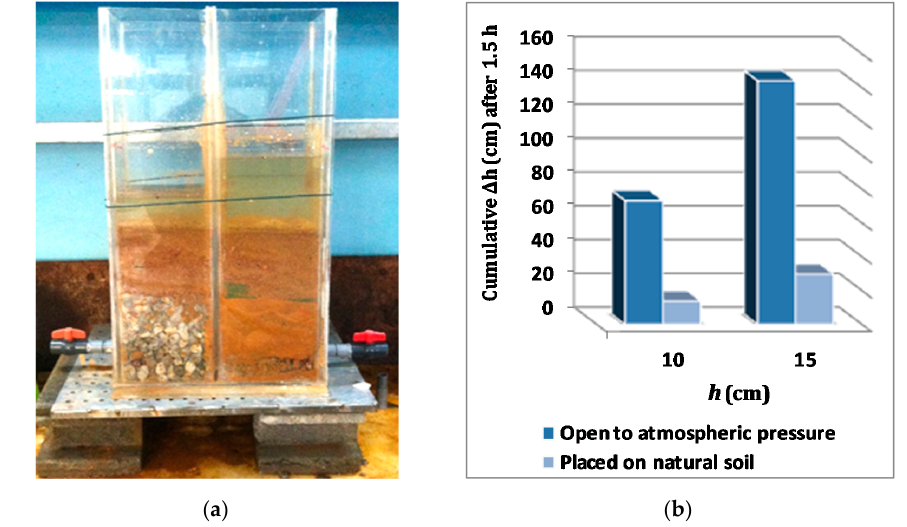
Figure 4. The laboratory conducted to measure the infiltration rates through a topsoil, open to atmospheric pressure and with natural soil boundaries: ( a ) the physical model with identical vertical columns ( b ); the cumulative infiltration after 1.5 h. [21]